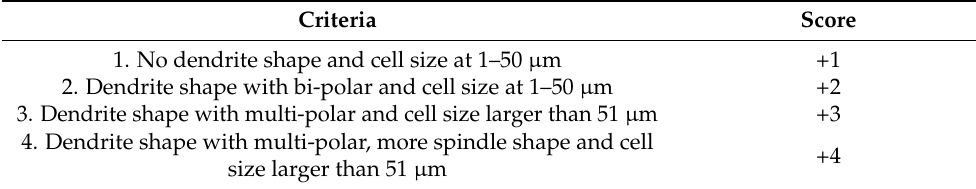
Table 1. The scoring criteria of morphology appearance in B16F10 cells.